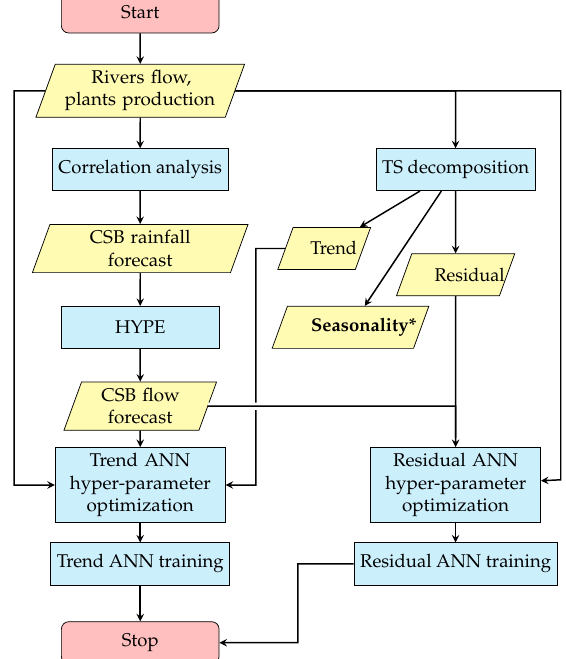
Figure 3. Hybrid ANN training flow chart; CSB stands for Correlated Sub-Basins.